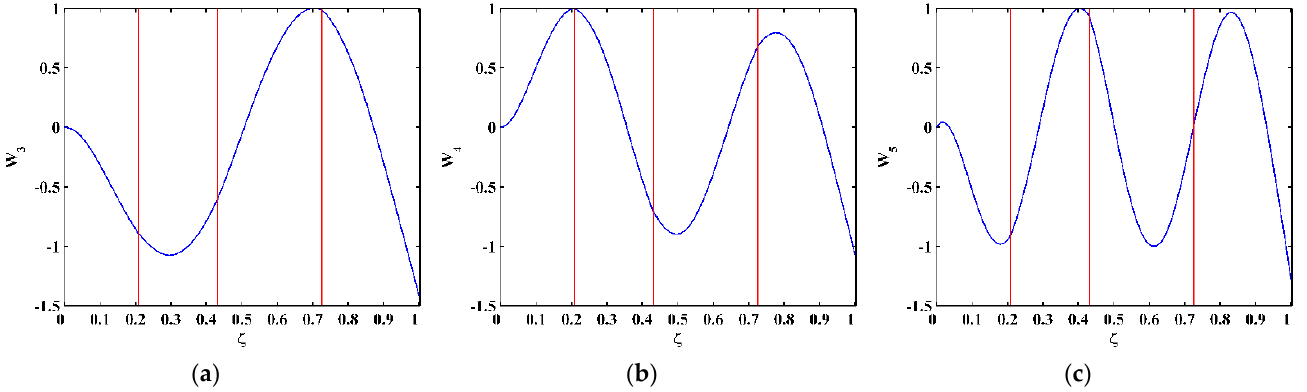
Figure 13. FRF of the CFRP laminated beam (the first five natural frequencies are marked by red dots).